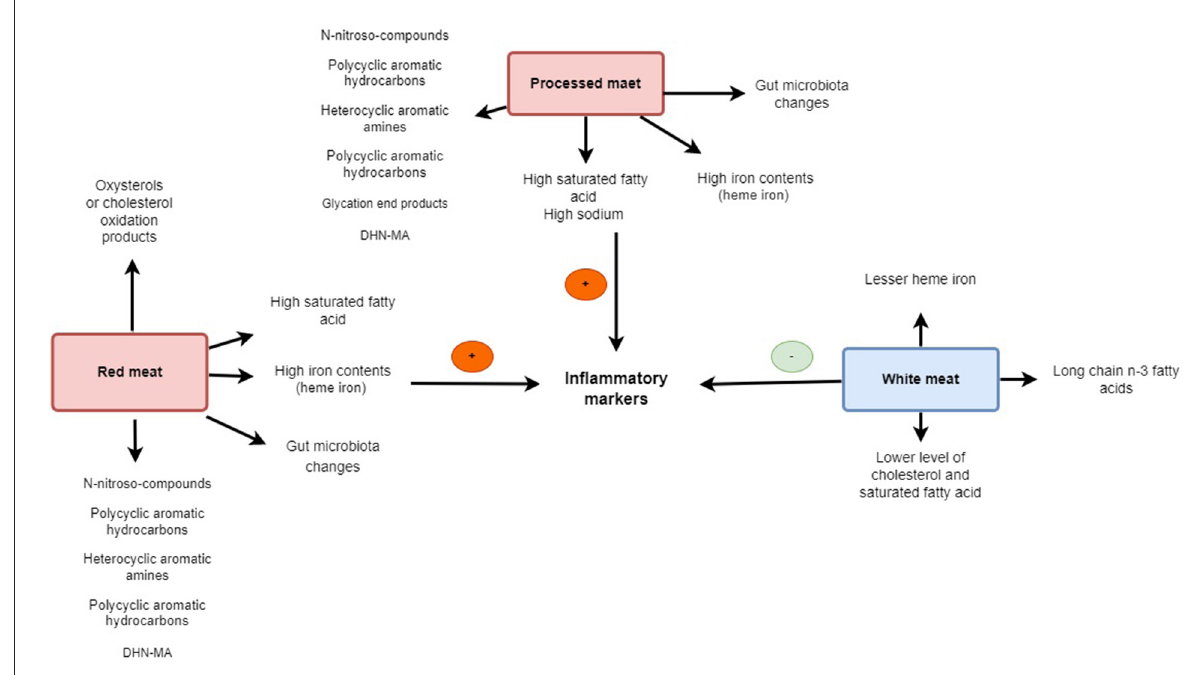
FIGURE1 The scheme illustrates the different mechanisms of red, processed, and white meat on